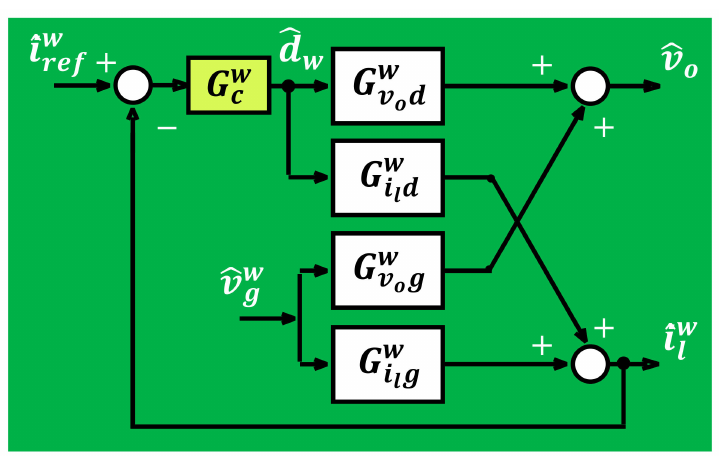
Figure 4. Current programmed boost converter model used with a wind